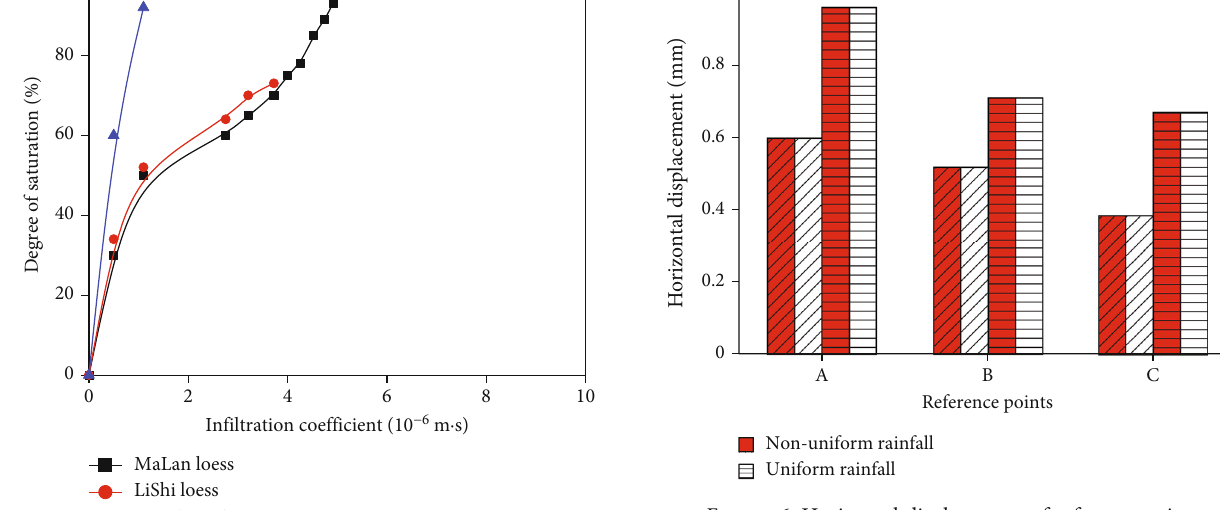
Figure 6: Horizontal displacement of reference